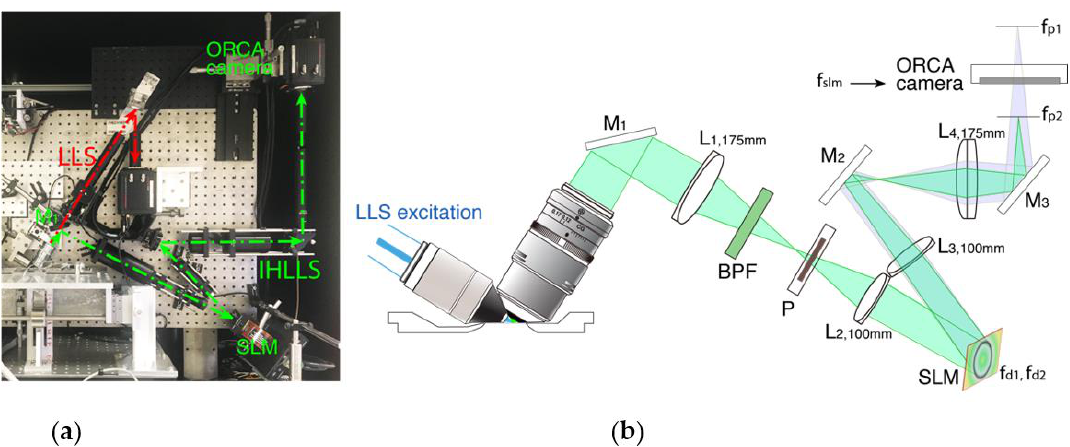
Figure 1. The detection modules of ( a ) the commercial LLS microscope, LLS (red), and incoherent holographic detection module, IHLLS (green). ( b ) The optical setup of the IHLLS detection module. The system consists of a water immersed microscope objective MO (Nikon 25X, NA 1.1, WD 2 mm), lenses L 1 = L 4 with focal lengths 175 mm, L 2 = L 3 with focal lengths 100 mm; mirrors M 1 , M 2 , M 3 ; polarizer P; 520 nm center wavelength, band pass filter BPF with bandwidth ∆ λ = 40 nm; and spatial light modulator SLM. The light propagates through either pathway 1 (red line in a ), for the original LLS, or pathway 2 (green line in a ) for IHLLS, depending on the orientation of sliding mir- ror.